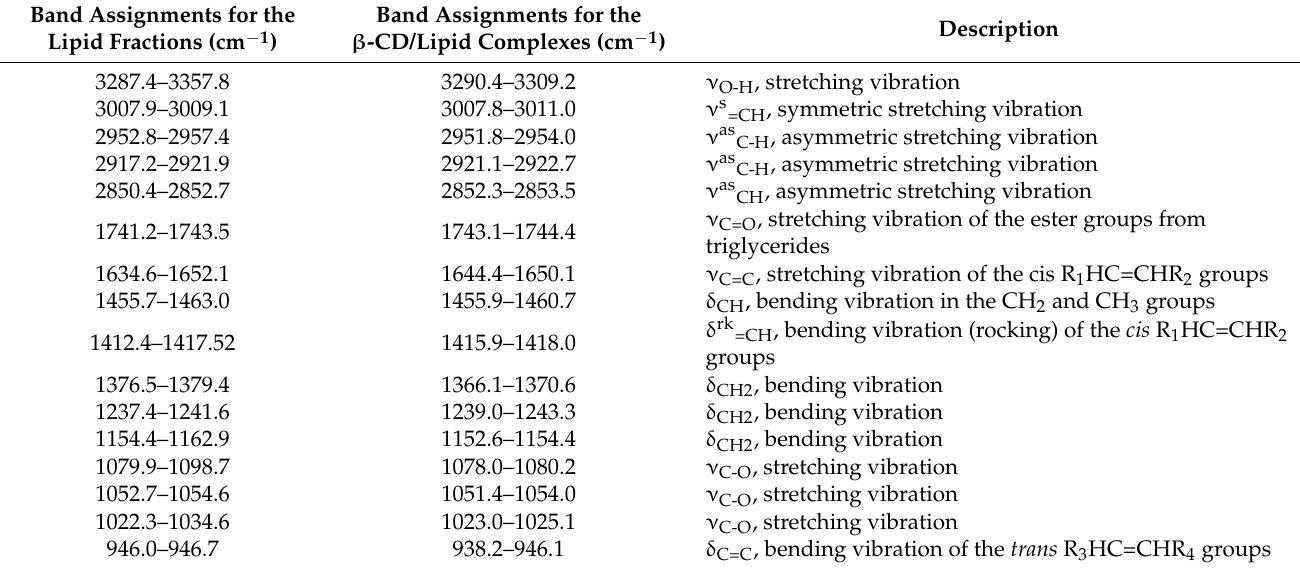
Table 1. Comparisons of the ATR-FTIR band assignments of the lipid fractions (chicken breast and thigh, unprocessed and processed) and the corresponding β -cyclodextrin/lipid complexes. Band Assignments for the Band Assignments for Lipid Fractions (cm − 1 )